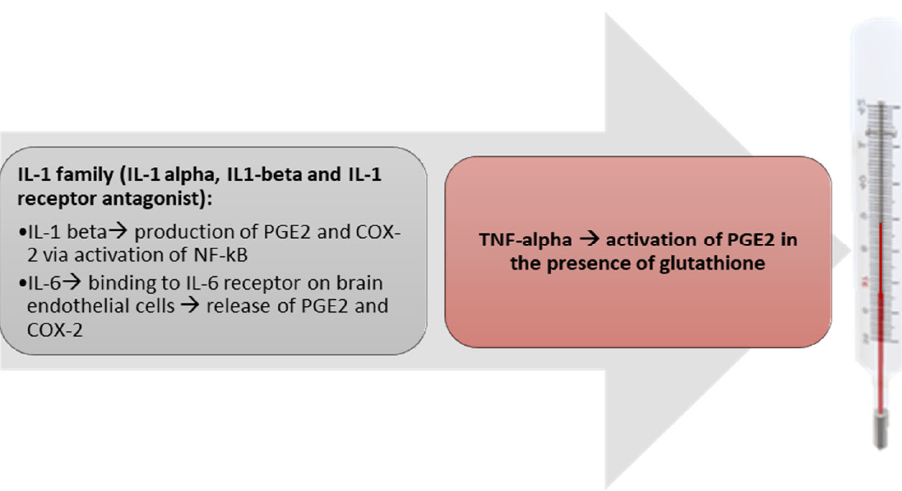
Figure 2. Pyrogenic cytokines. Main mechanisms of fever elicited by IL-1, IL-6 and TNF-alpha are are described.